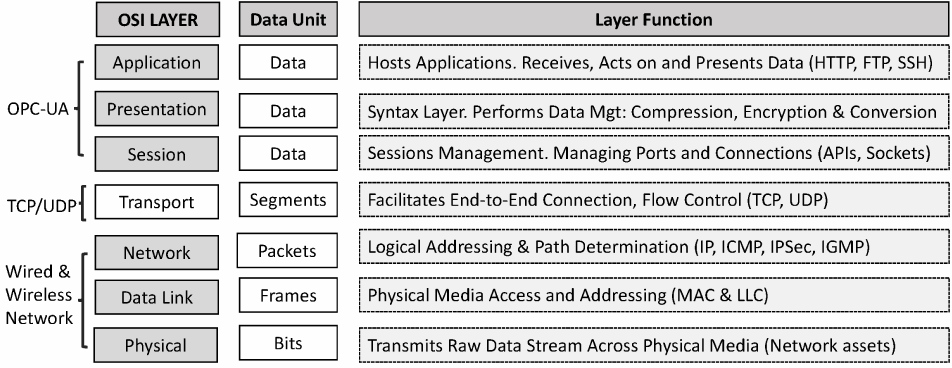
Figure 10. The seven OSI